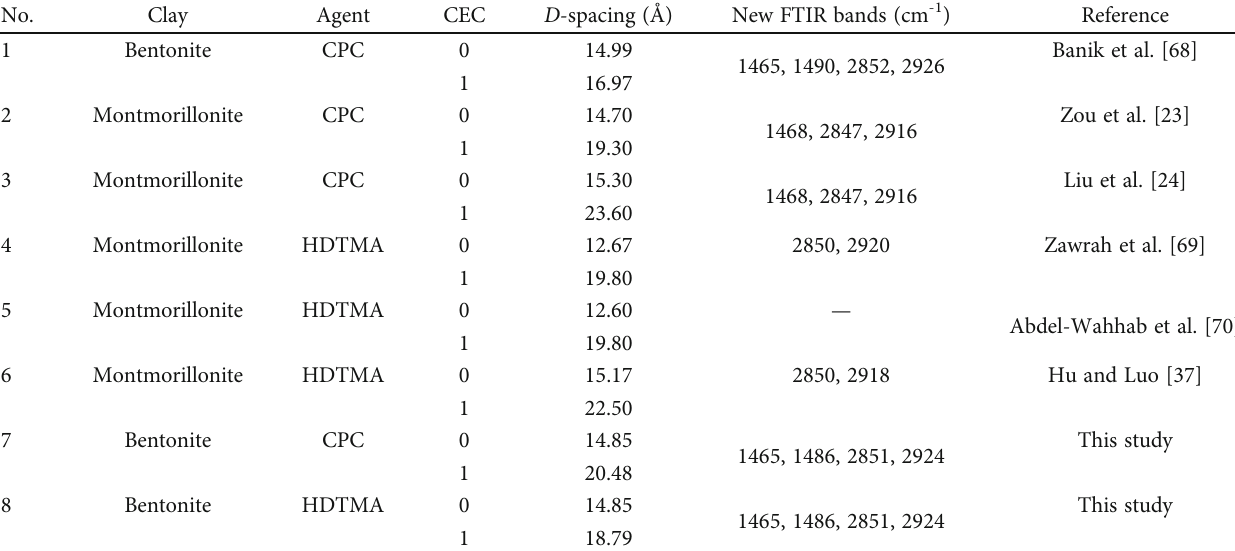
Table 7: The comparison of chemical and physical characteristics.